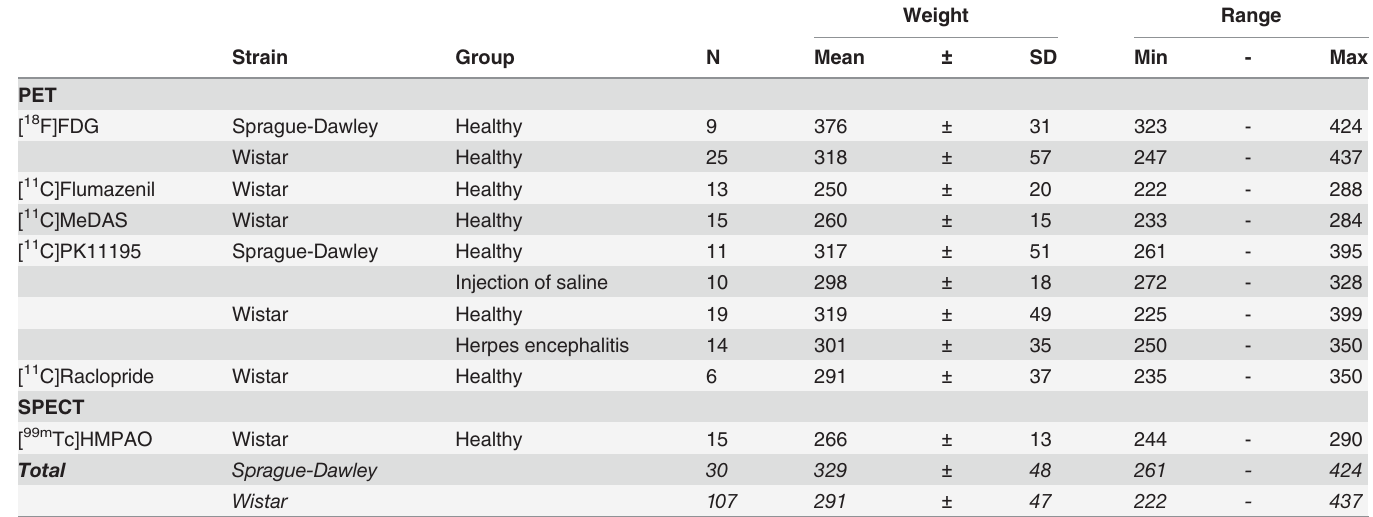
Table 1. Distribution of the rats across experimental